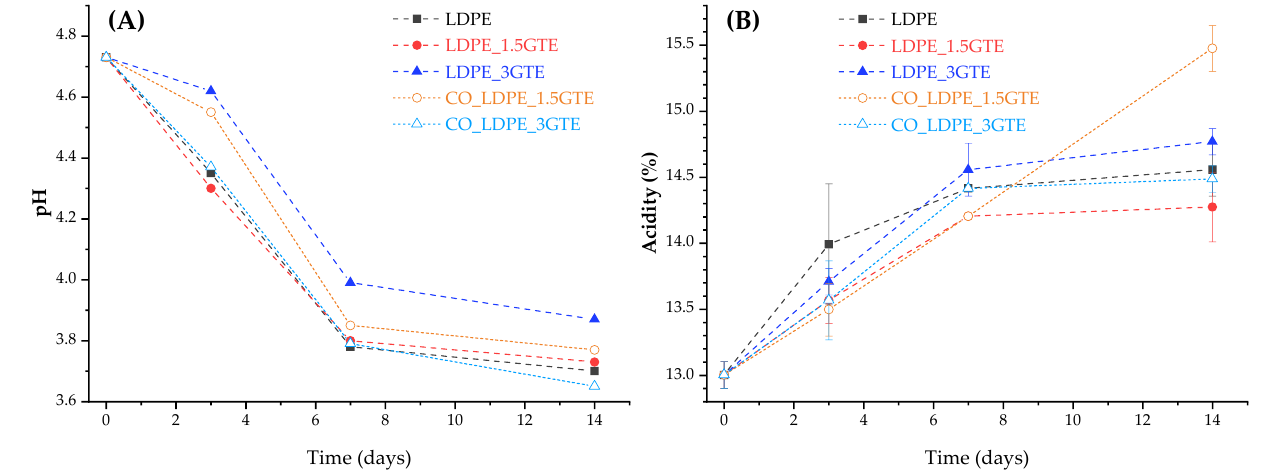
Figure 2. pH indexes (A), and TA (B) of orange juice packed in active LDPE films containing GTE and stored at 4 °C for 14 days.